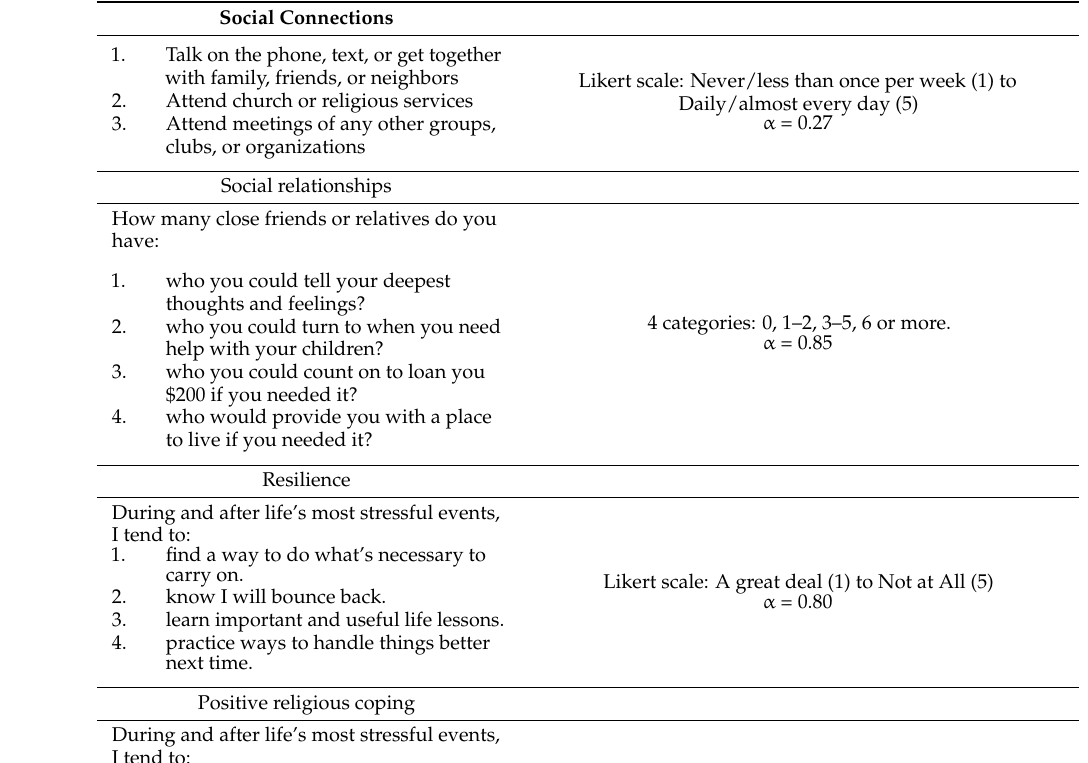
Table 2. Measures of Resources and Protective